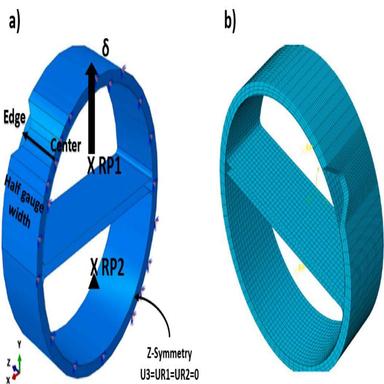
(a) half of the CAD model for the ring hoop plane strain test; (b) three-dimension finite element mesh.